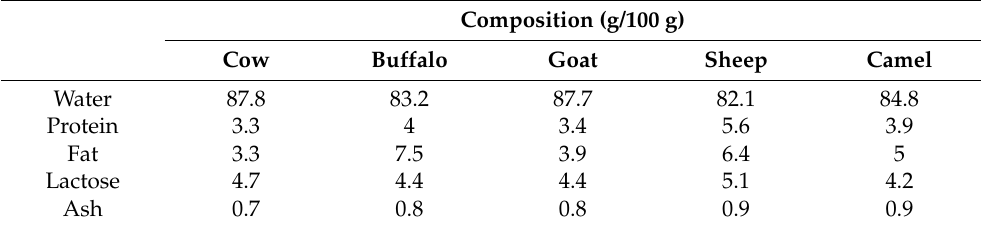
Table 1. Nutritional composition of some of the most consumed milks in the world. Composition (g/100 g) Cow Buffalo Goat Sheep Camel Water 87.8